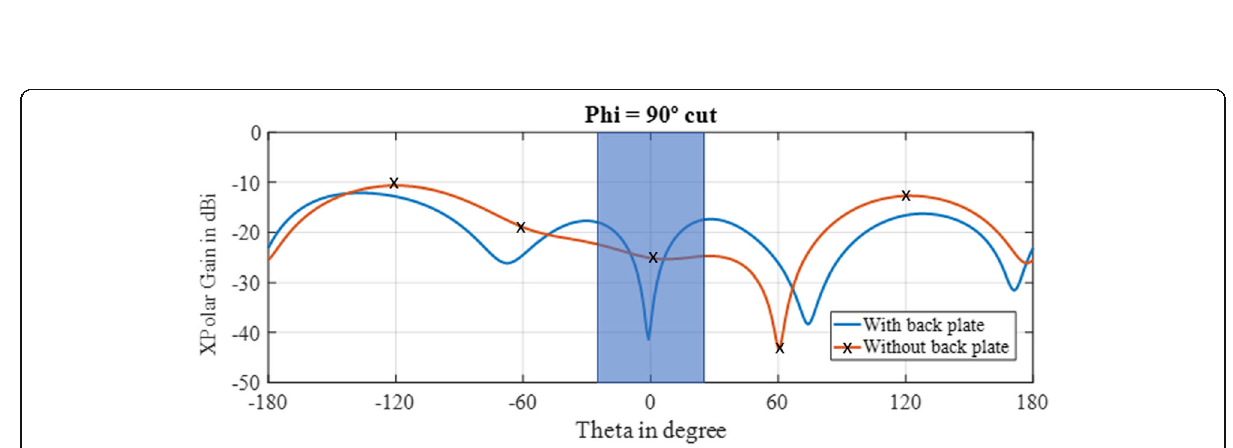
Fig. 18 XPD cross polar discrimination comparison for cases of without and with back